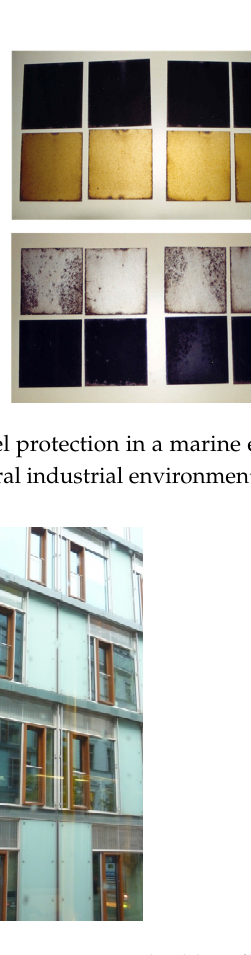
Figure 3. Aluminium components in a building façade.